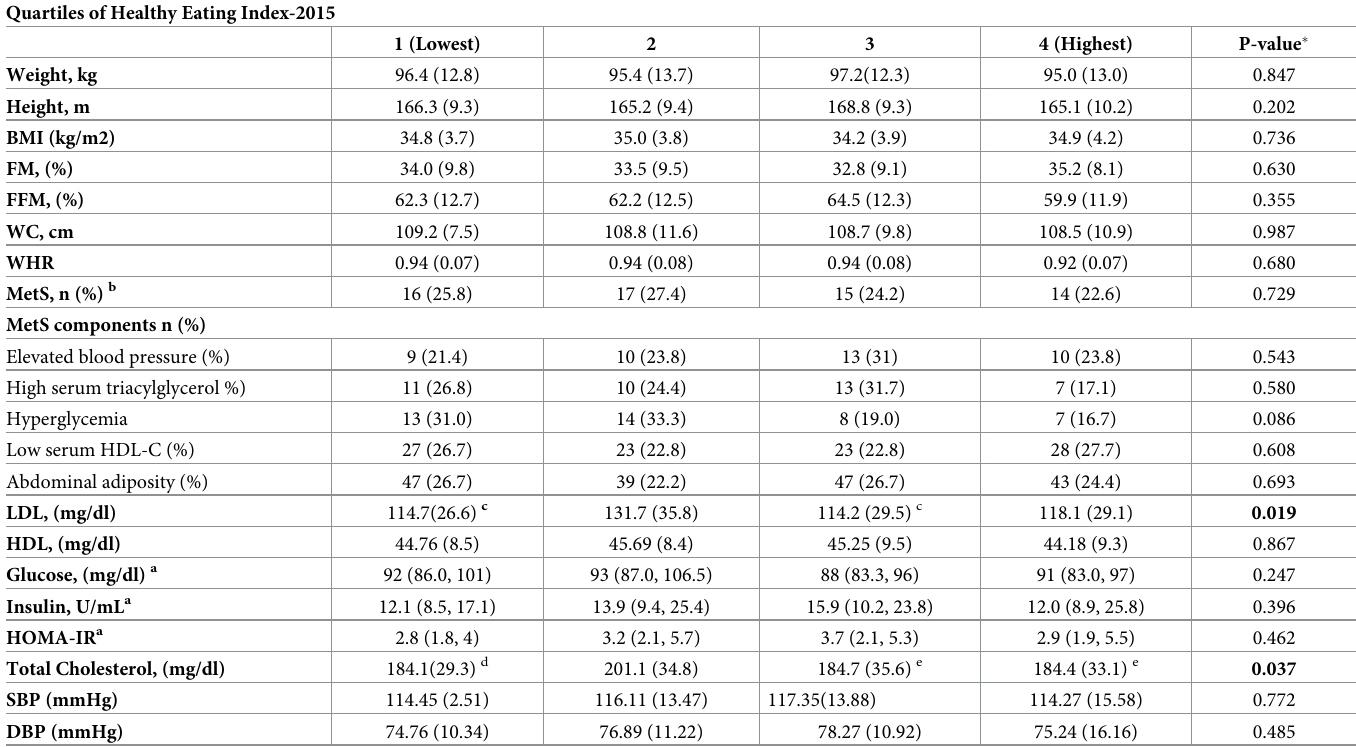
Table 3. Anthropometric and metabolic parameters of study participants by quartiles of Healthy Eating Index-2015. Quartiles of Healthy Eating Index-2015